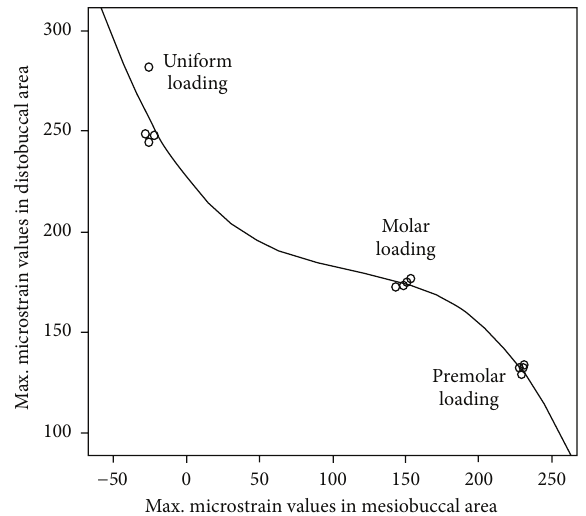
Figure 5: An inverse correlation between maximum microstrain of the mesiobuccal area next to the rest versus the distobuccal area next totheimplantastheloadingpointmovesfromuniformtomolarand then